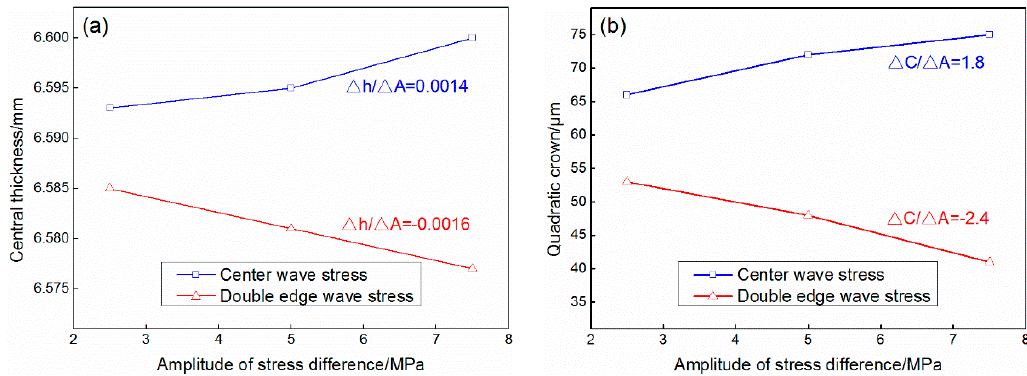
Figure 17. Efficacy coefficient of quadratic wave stress on central thickness and quadratic crown: ( a ) efficacy coefficient on the central thickness; and ( b ) efficacy coefficient on the quadratic crown.